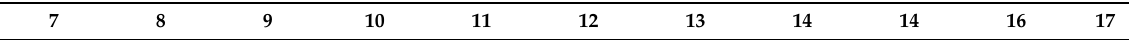
Table 2. Pearson correlation [ r ] between stress and other work-related